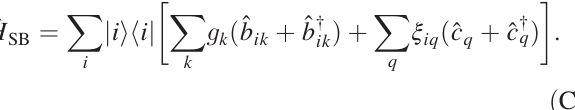
FIG. 5. Collective modes in a molecular dimer. (a) If the two molecules immersed in an elastic medium (roughly modeling the protein environment) have the same orientation, only the anti- symmetric superposition of local vibrational modes causes stretching or compression of the medium. (b) If the molecules have opposite orientation (like two neighboring B850 pigments in LH2), the symmetric superposition of local modes causes stretching or compression of the